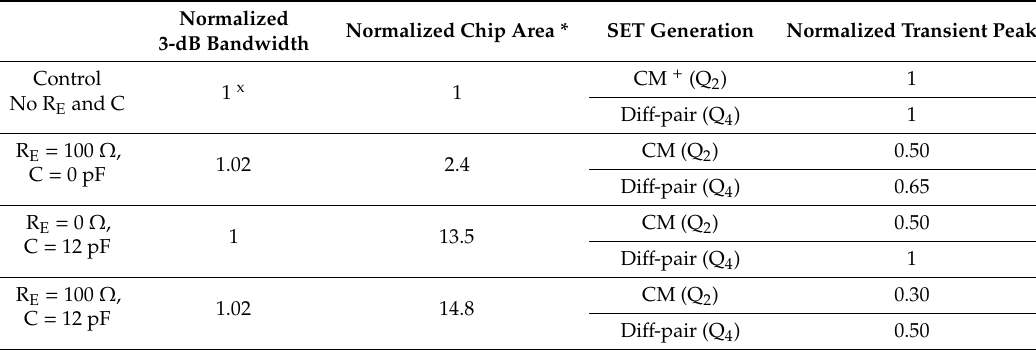
Table 1. Comparison of CML